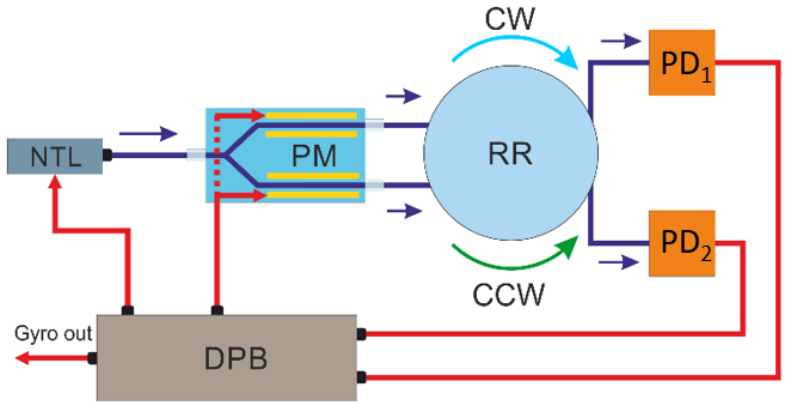
Figure 1. The scheme of the resonator gyroscope, implementing the principle of frequency synchro- nization. In the Figure: NTL—narrow tunable laser, PM—phase modulator, RR—ring resonator, PD—photodetector, DPB—digital processing